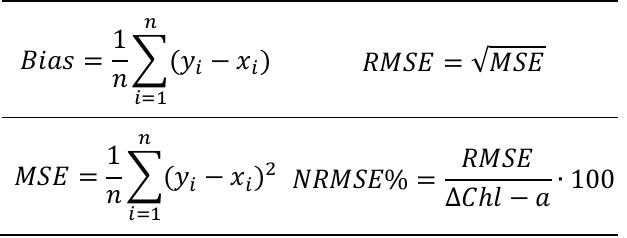
Table 3. Summary of the error estimators used. Where: y i and x i are the predicted and the measured chl- a concentration respectively in each i sample.